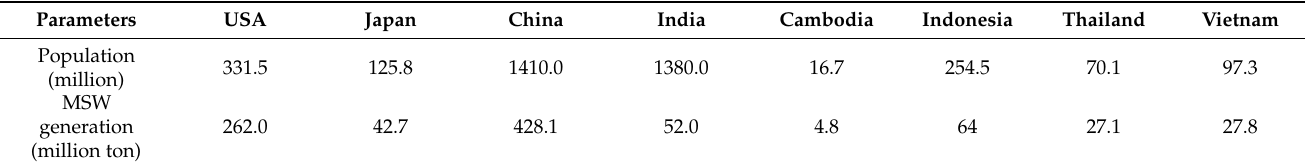
Table 5. Comparison of MSW management with other